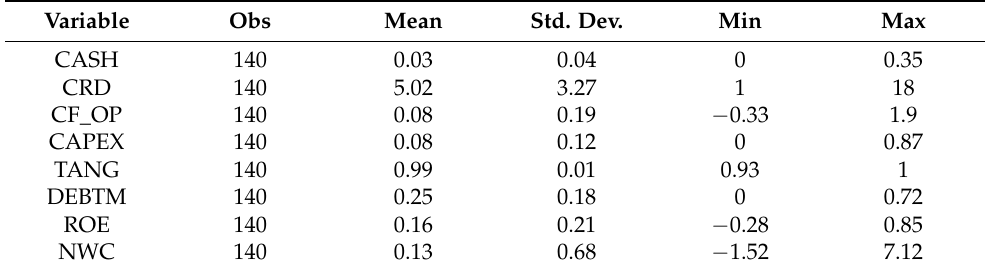
Table 3. Descriptive statistics for continuous